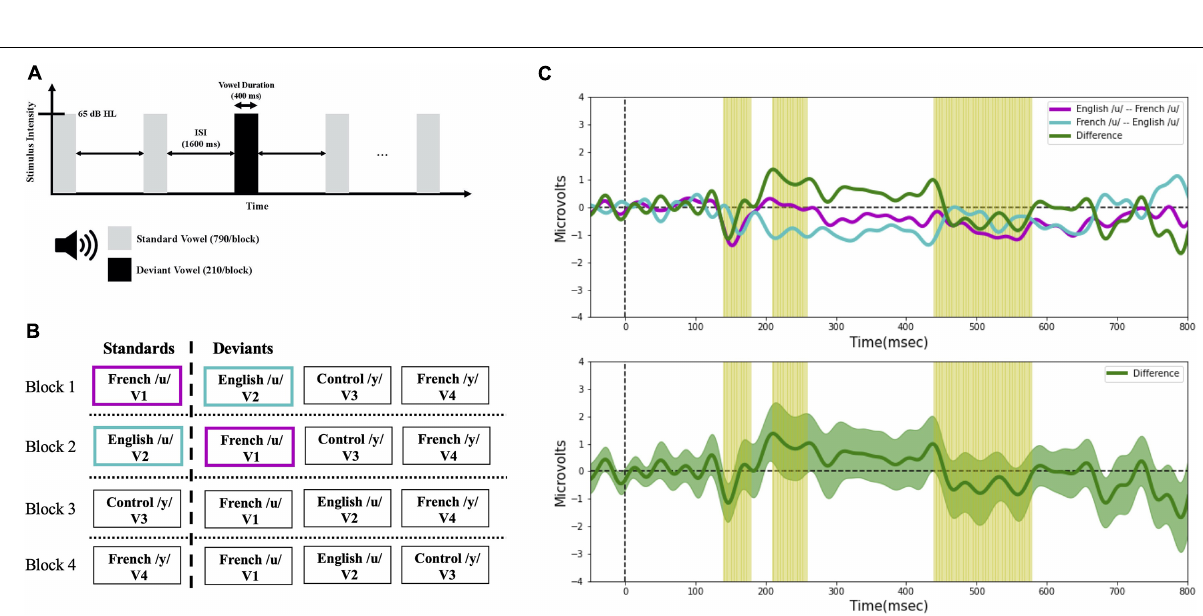
Frontiers in Human Neuroscience |